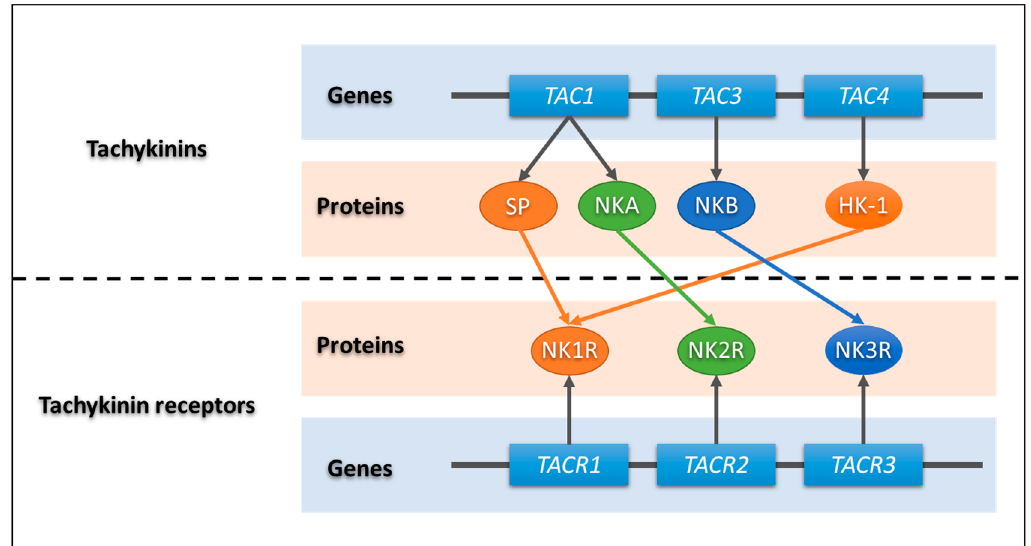
Figure 1. Genetic coding scheme of the tachykinins and their receptors. TAC1 , tachykinin precursor 1 gene; TAC3 , tachykinin precursor 3 gene; TAC4 , tachykinin precursor 4 gene; SP, substance P; NKA, neurokinin A; NKB, neurokinin B; HK-1, hemokinin-1; TACR1 , tachykinin receptor 1 gene; TACR2 , tachykinin receptor 2 gene; TACR3 , tachykinin receptor 3 gene; NK1R, tachykinin receptor 1; NK2R, tachykinin receptor 2; NK3R, tachykinin receptor 3.